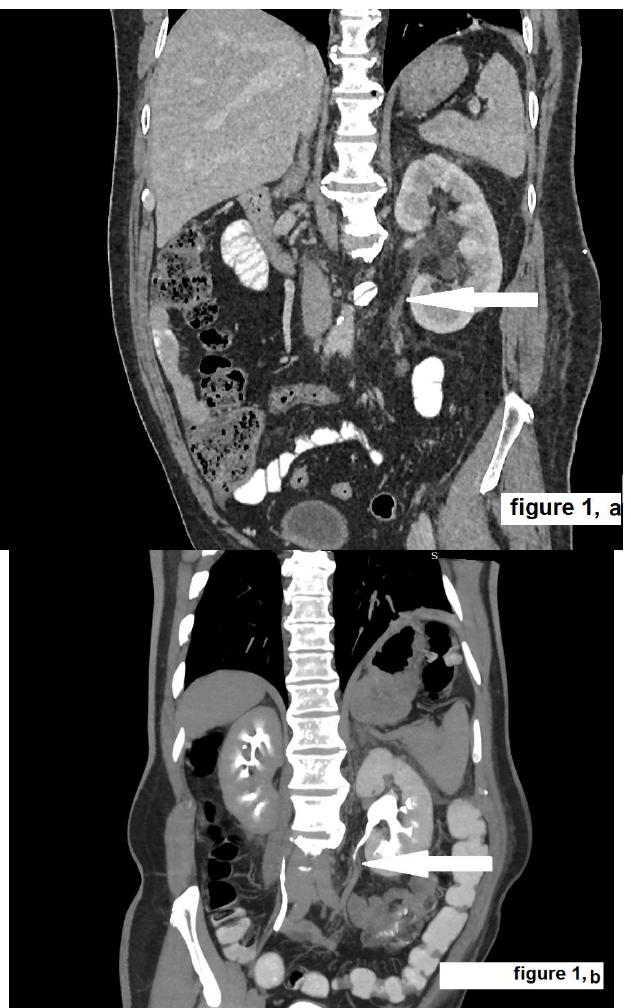
Figure. 1 (a, b) Triphasic urinary tract computed tomographic scan (CT) (a) An area of ureteric wall enhancement detected(arrowed)